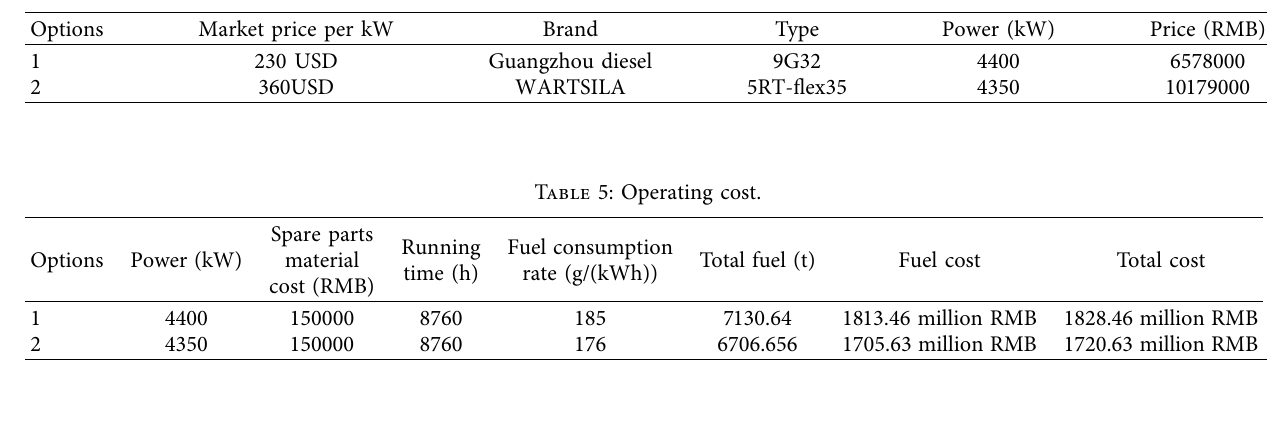
Table 4: Price list for diesel engines.